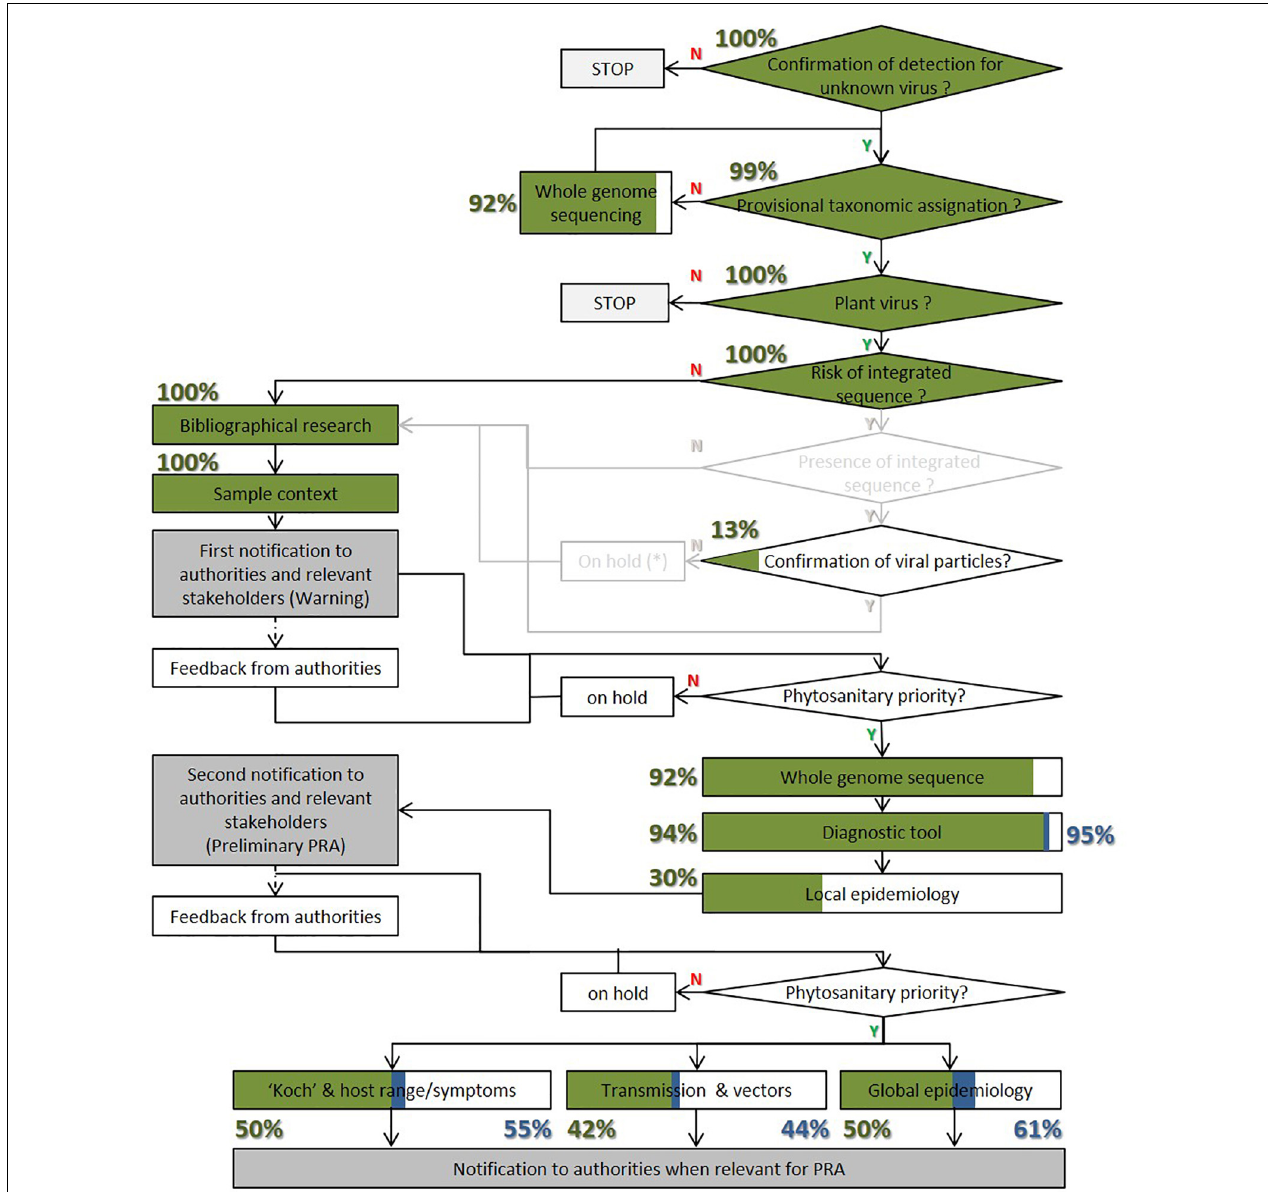
FIGURE 3 | Fulfillment evaluation of a previous published framework for efficient characterization of new phytoviruses (Massart et al., 2017) for the newly discovered fruit tree viruses. Green box and percentage numbers represent the rate of framework completion in the first publication of a new fruit tree virus. Blue box and percentage numbers represent the rate of framework completion for the citing publications and the original one.